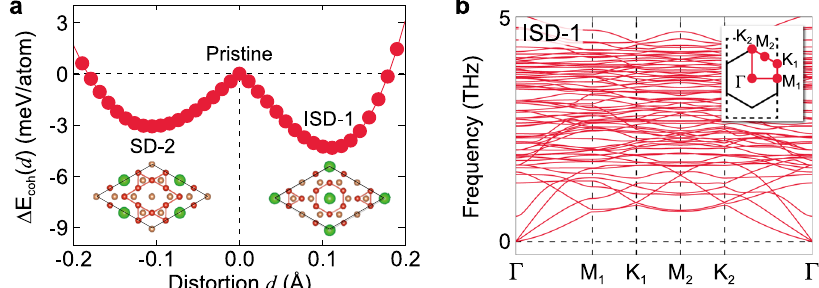
Fig. 6 | Stability of the A V 3 Sb 5 monolayer. a Cohesive energy difference (per atom)asafunctionoftheCDWdistortion d oftheKV 3 Sb 5 monolayer.Thecohesive energy difference is de fi ned as Δ E coh ( d )= E coh ( d =0) − E coh ( d ), where the positive (negative) value of the distortion d represents the shift of the V atom in the ISD-1